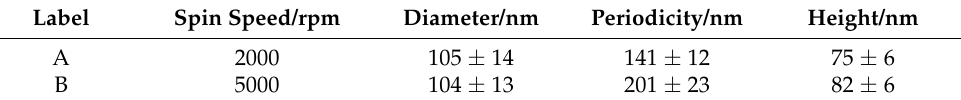
Table 2. Characteristic dimensions of the nanopillar arrays determined by AFM and SEM. (For easier understanding of subsequent results, nanoarrays were labeled as A and B).